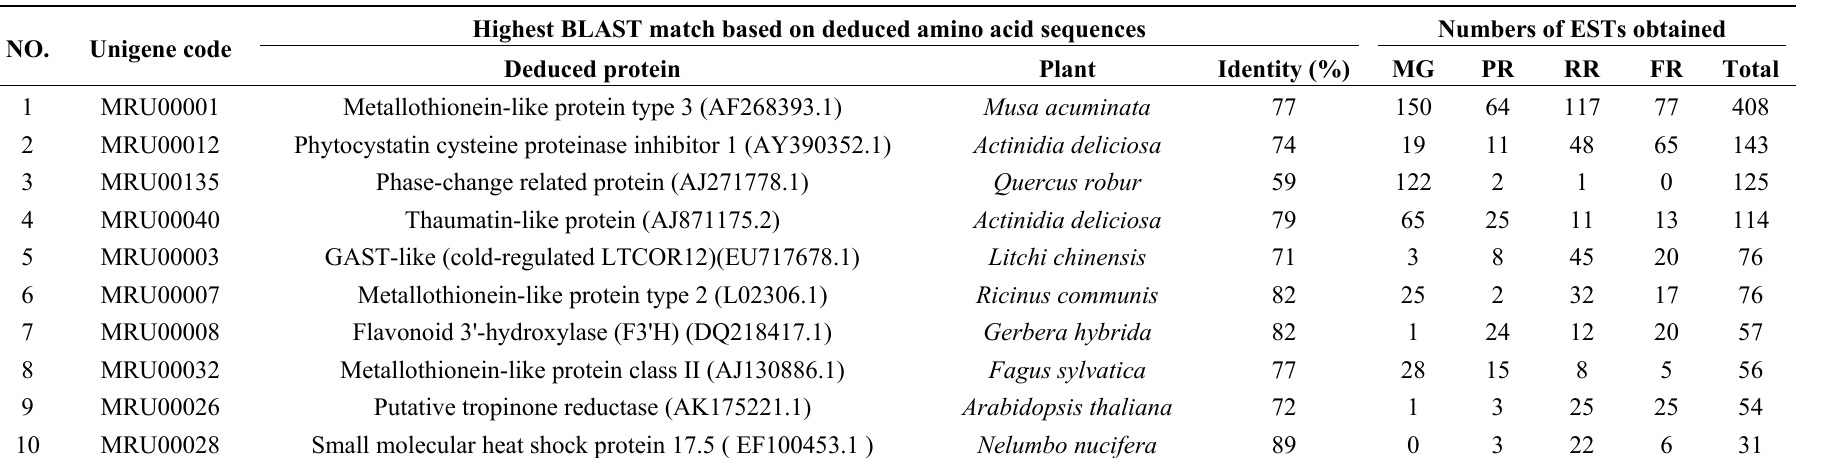
Table 3. Analysis of highly expressed genes from “Biqi” fruit